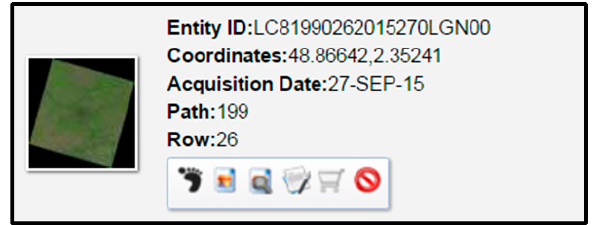
Figure 5. Icons associated with image and scene options.